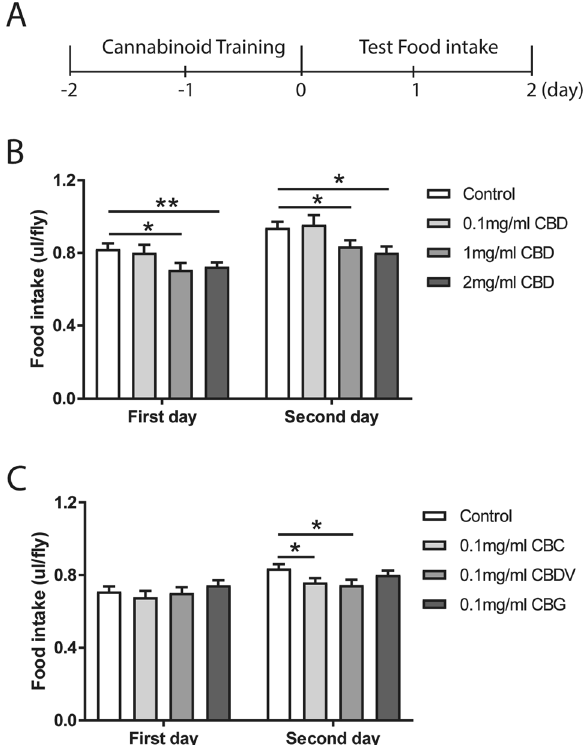
Figure 4. Phytocannabinoids reduce food intake in flies. ( A ) A diagram of the experimental scheme for the food intake assays. Following two days of cannabinoid treatment (day -2 and day -1), the normal food intake by the flies was measured for two consecutive days (day 1 and day 2) as depicted in the histograms ( B , C ). ( B ) CBD at 1 mg/ml and 2 mg/ml, but not at 0.1 mg/ml, significantly decreased normal food intake on both day 1 and day 2 (n = 13–19 vials/group). ( C ) Pre-treatment with 0.1 mg/ml CBC and CBDV, but not with CBG, led to significant reductions in food intake on day 2 (n = 32–33 vials/group). All data are represented as mean ± S.E.M. One-way ANOVA followed by Dunnett’s post-hoc test. * p < 0.05 and ** p <